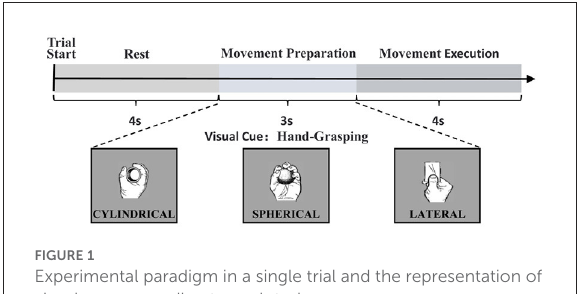
frequency of 2,500 Hz, recording experimental data for a